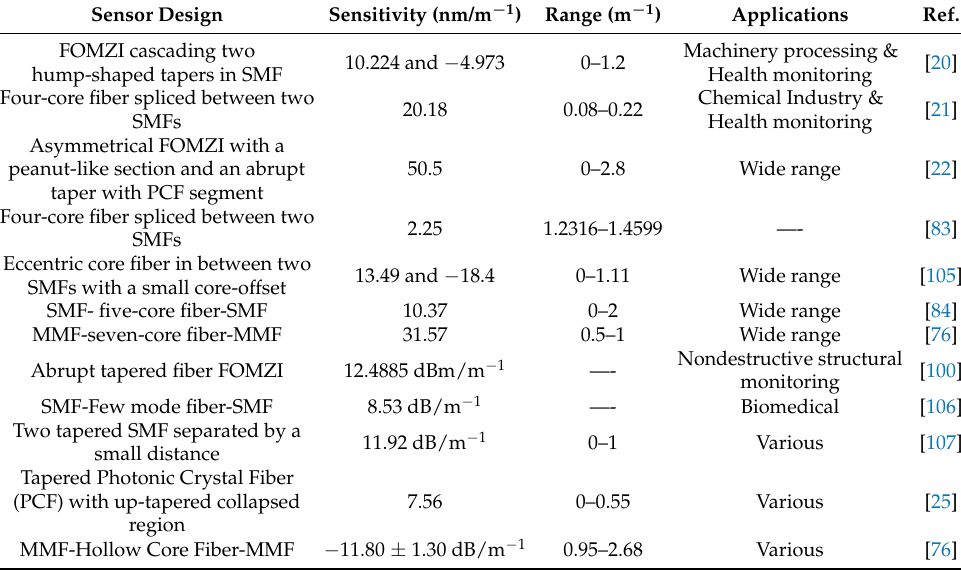
Table 5. Curvature sensitivity of FOMZI. Sensor